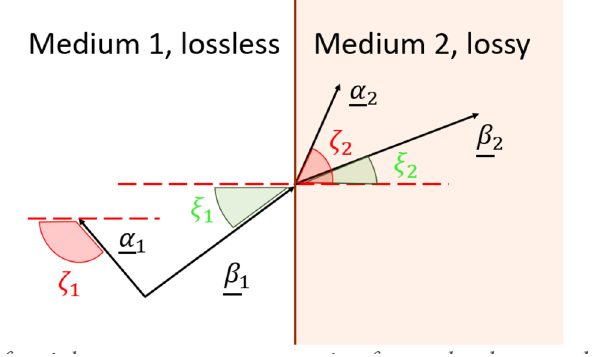
Figure 1. Case of incidence of an inhomogeneous wave coming from a lossless to a lossy medium. The interface between the media is planar, highlighted in red in the